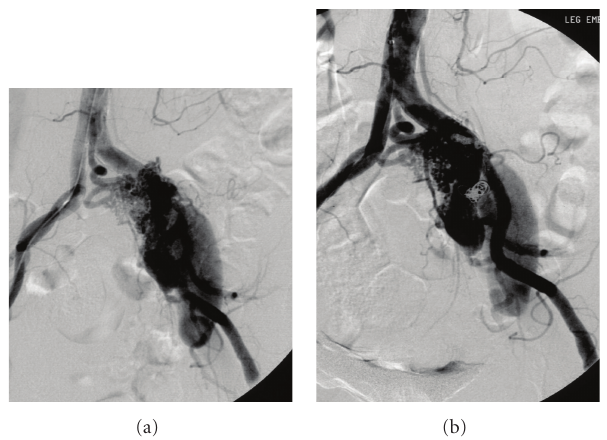
Figure 5: (a) Arteriogram of the AVM, preembolization, left 5th lumbar artery (arrow head) and the left internal iliac artery (arrow) are the major feeding vessels. (b) Postembolization with Onyx (EV3, Irvine, CA, USA) and coils (Cook Inc).